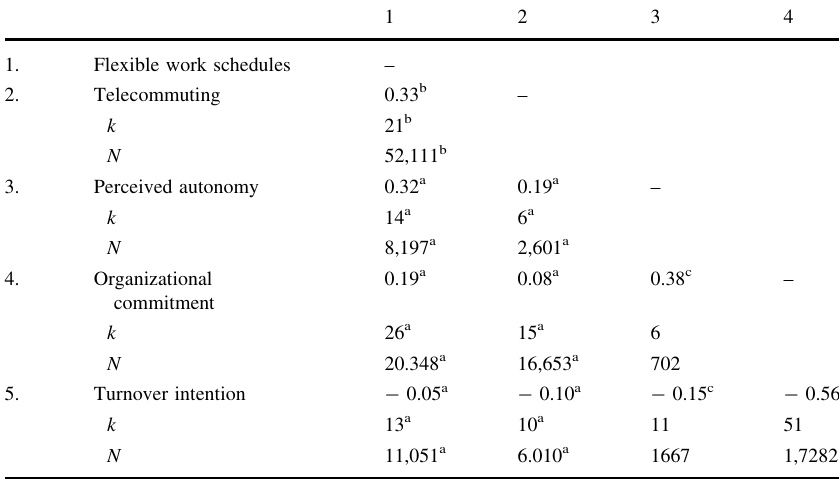
Table 5 Meta-analytic correlations between FWPs and internal outcomes